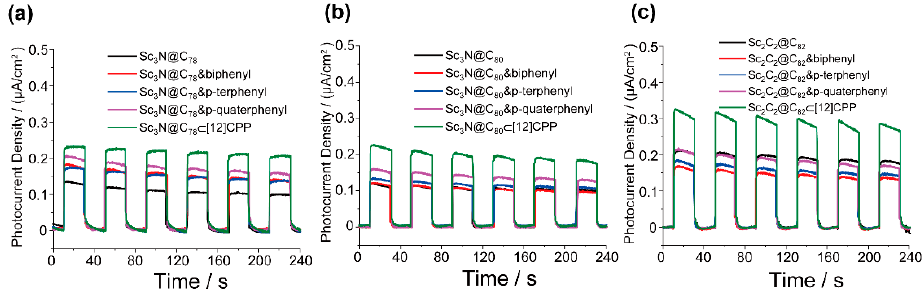
Figure 5. Photocurrent responses of ( a ) Sc 3 N@C 78 , ( b ) Sc 3 N@C 80 , and ( c ) Sc 2 C 2 @C 82 complexed with biphenyl, p − terphenyl, p − quaterphenyl, and [12]CPP, respectively.